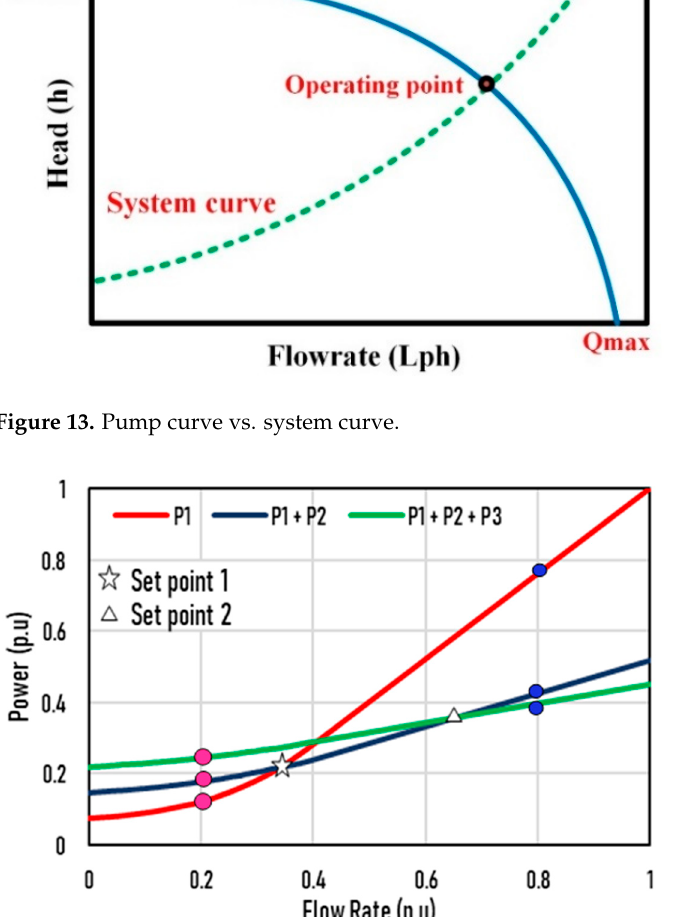
Figure 14. Single and multi ‐ parallel power curve.